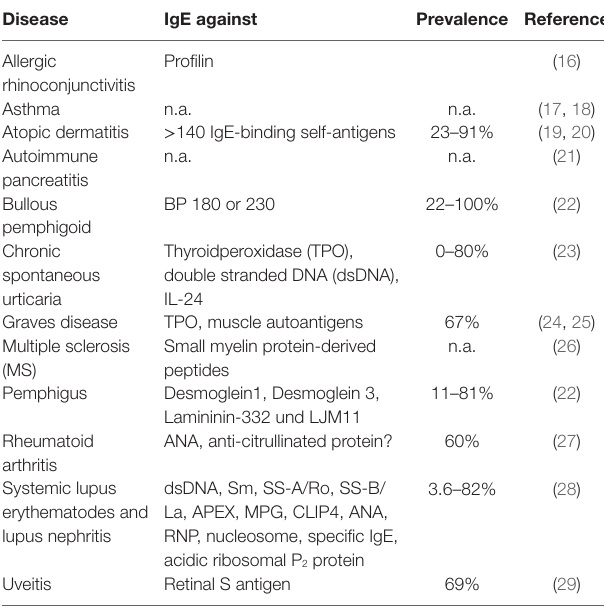
TAble 1 | Percentage of patients in which immunoglobulin E (IgE) autoantibodies have been detected in various